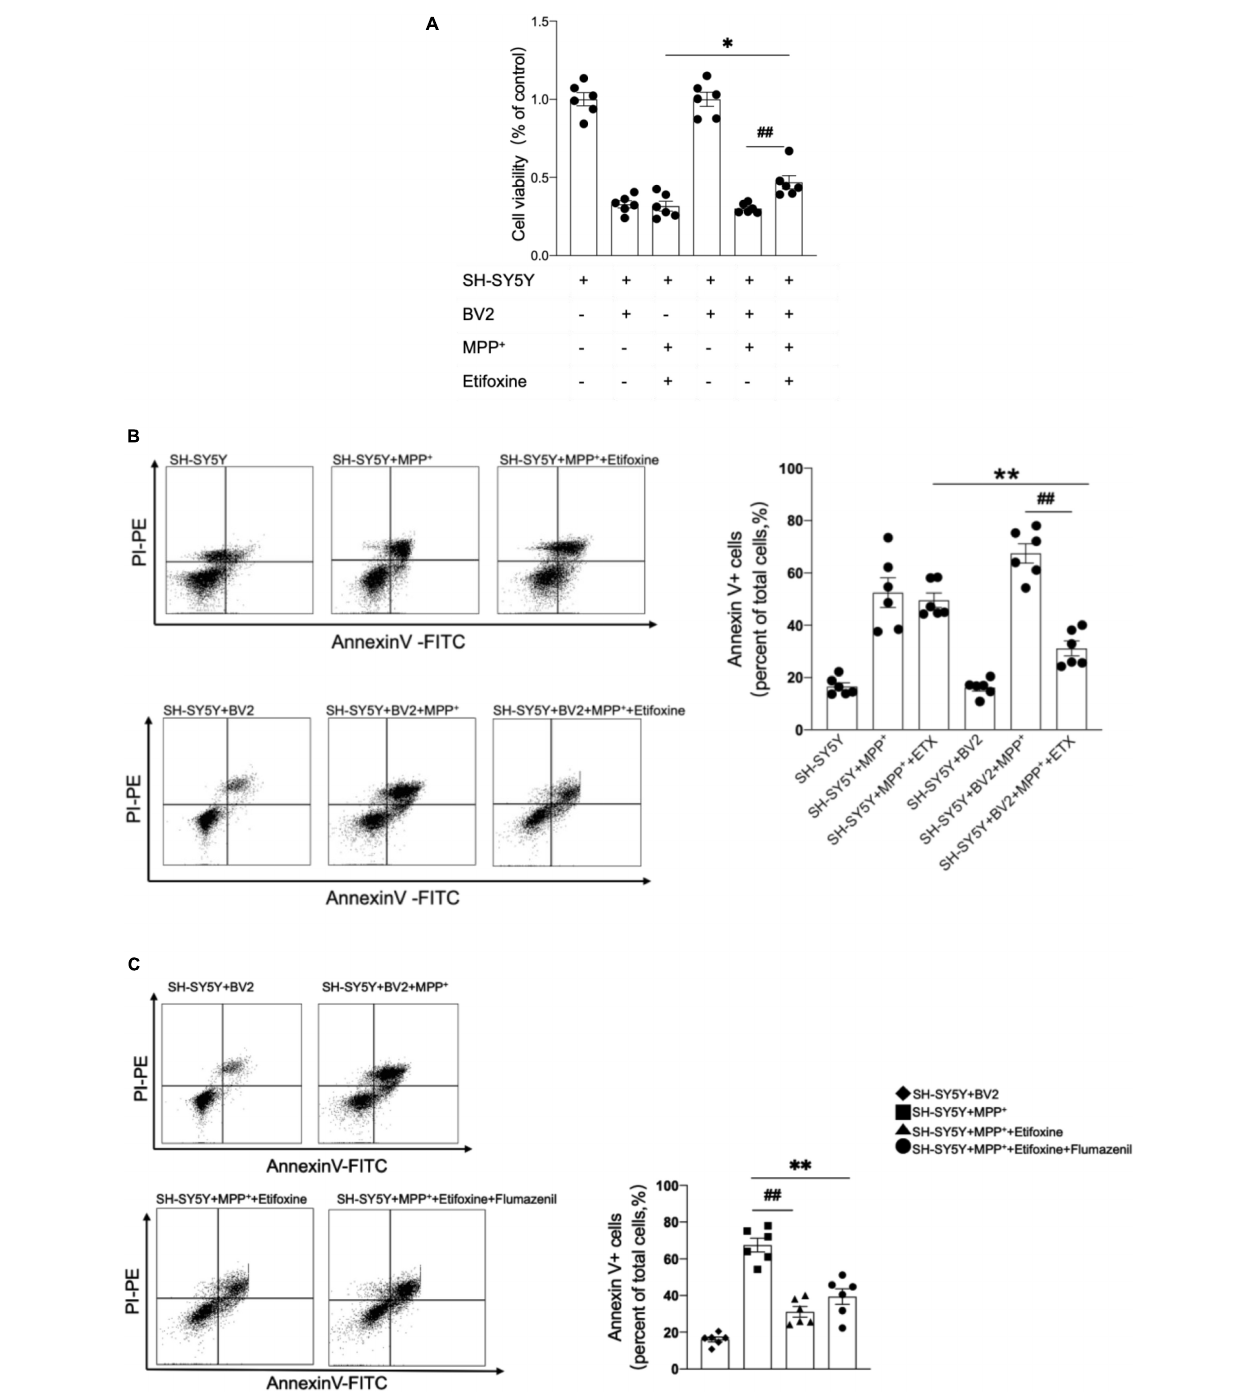
FIGURE 5 | The neuroprotective effect of etifoxine depended on microglia. (A) SH-SY5Y cells and BV2 microglia were co-cultured in DMEM-F12 medium and incubated with 0.5 mmol/L MPP + for 24 h then 0.02 mmol/L etifoxine for 24 h. Bar graph showing the activity of SH-SY5Y cells and BV2 cells treated with MPP + and etifoxine. The absorbance was measured at 490 nm, and the reference wavelength was 630 nm. F (5,30) = 96.46, ## P = 0.02, * P = 0.04. (B) Flow cytometry plots showing the gating strategy for apoptotic cells (Annexin V + cell). Bar scatter plot to quantify apoptotic cells. F (5,30) = 3.345, ∗∗ P = 0.005, ## P < 0.001. (C) Cells were treated with 0.2 mM flumazenil for 15 min. Scatter plots indicate apoptosis. F (3,20) = 2.162, ∗∗ P < 0.001, ## P < 0.001. All data were expressed as mean ± SEM. ( n = 6 of independent cell cultures) ∗ P < 0.05, ∗∗ P < 0.05.